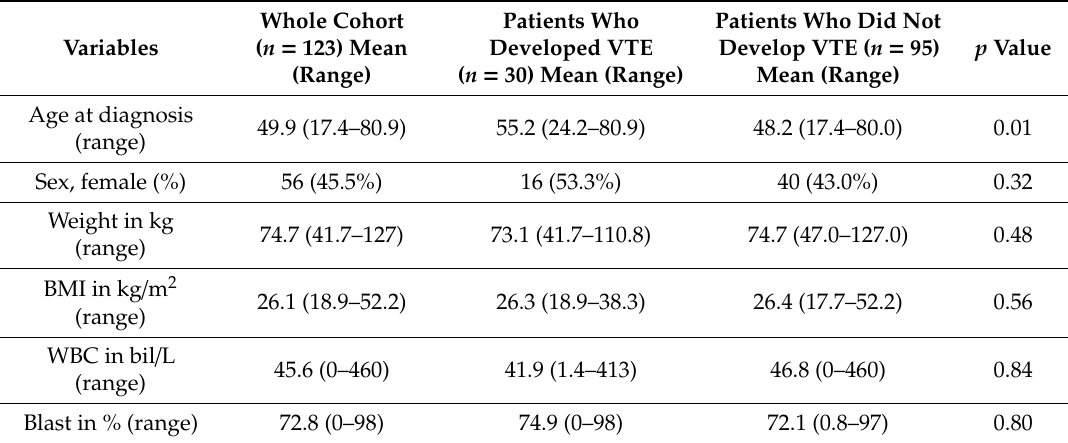
Table 1. Baseline Patient